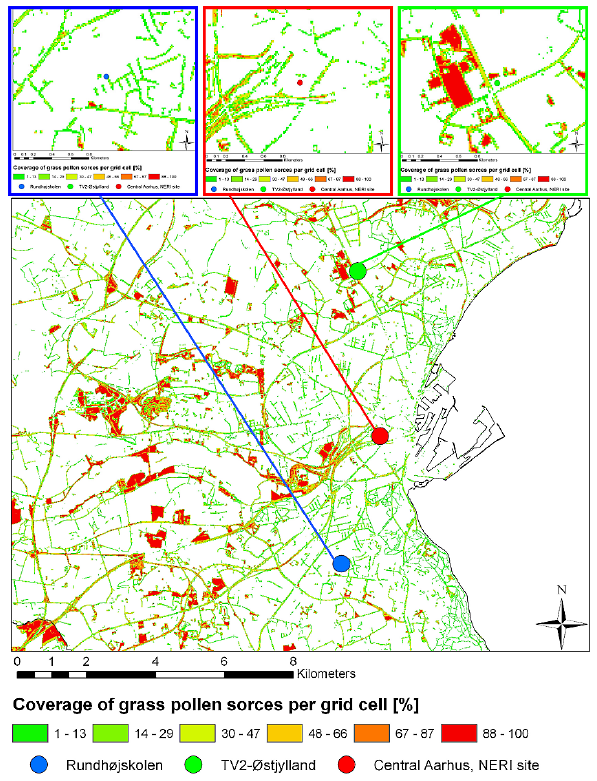
Fig. 8. Inventory of high-emitting grass pollen areas in the city of Aarhus (below) and zoom (top) that provides the vicinity of the three pollen monitoring